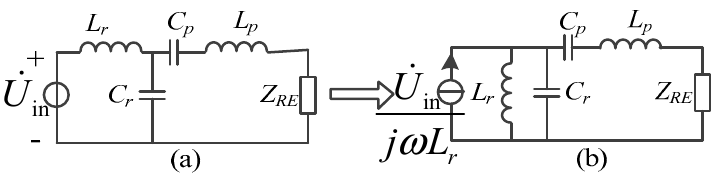
Figure 6. Equivalent transformation of LCC compensation.